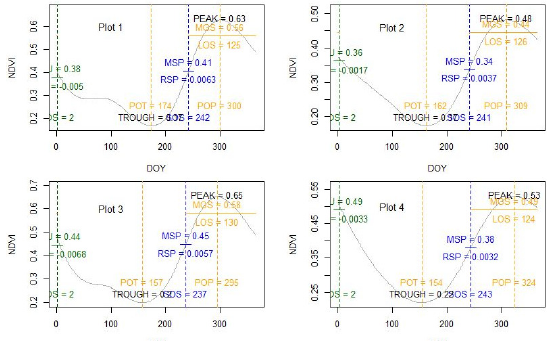
Figure 6. Estimated citrus crop growth stages for selected